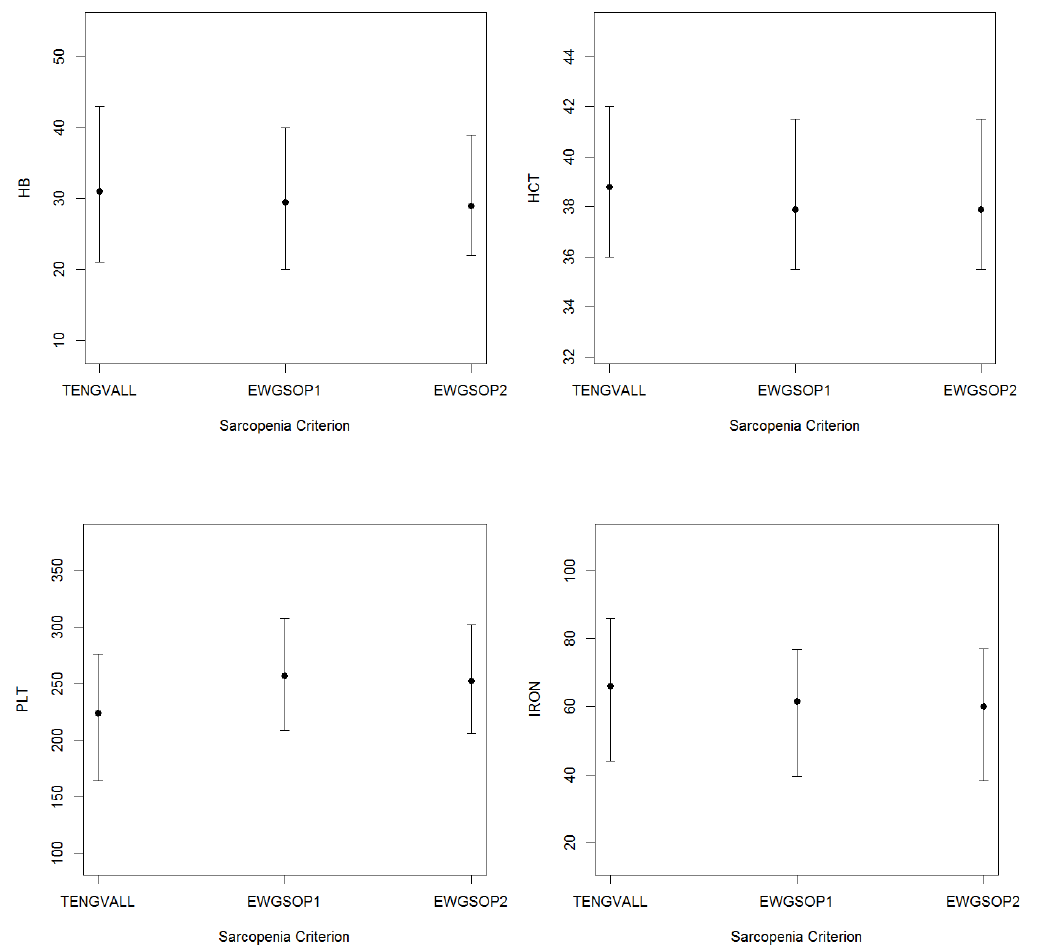
Figure A2. Summary of patients with low ASMI characteristics under each diagnostic criterion. The points represent medians, while lowers are upper quartiles are represented by the vertical bars.